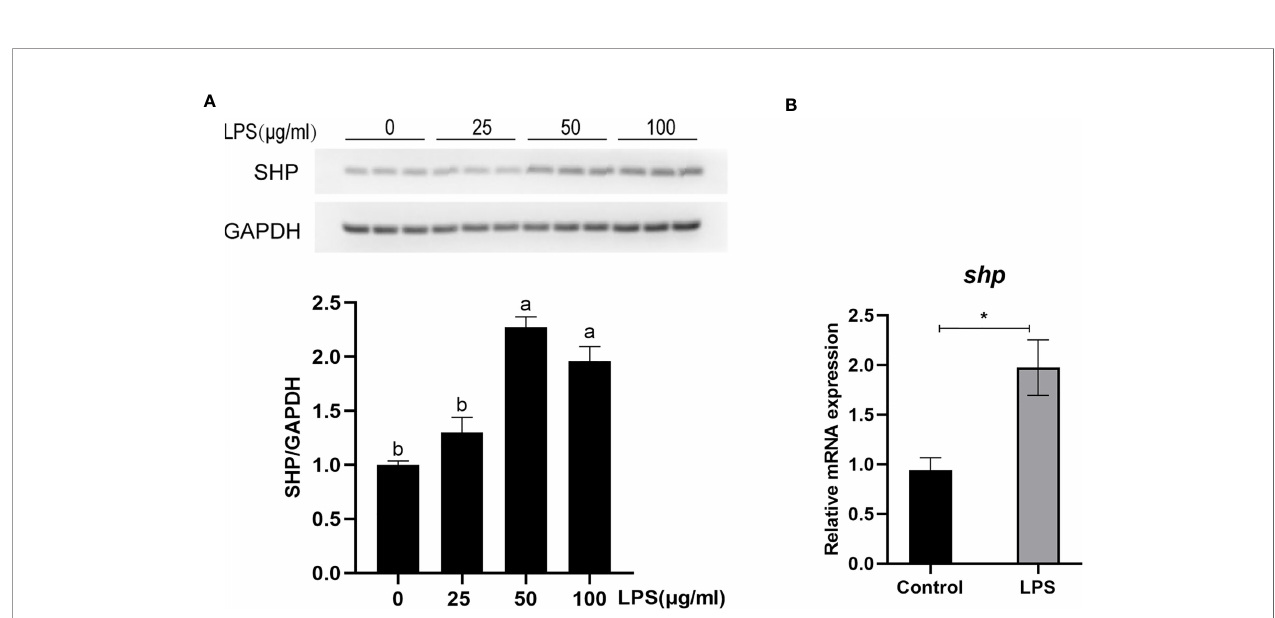
FIGURE 6 | LPS induces the expression of SHP in large yellow croakers. (A) Immunoblots for SHP in macrophages after LPS stimulation. (B) Gene expression of shp in macrophages after LPS stimulation. Data are presented as means ± SEMs, n = 3 replicate experiments. Signi fi cance was evaluated by one-factor ANOVA followed by Duncan ’ s multiple range test. Labeled means without a common letter differ, P < 0.05. ∗ Different from control, P < 0.05 (Student ’ s t -test). LPS, lipopolysaccharide; SHP, small heterodimer partner; GAPDH, glyceraldehyde-3-phosphate